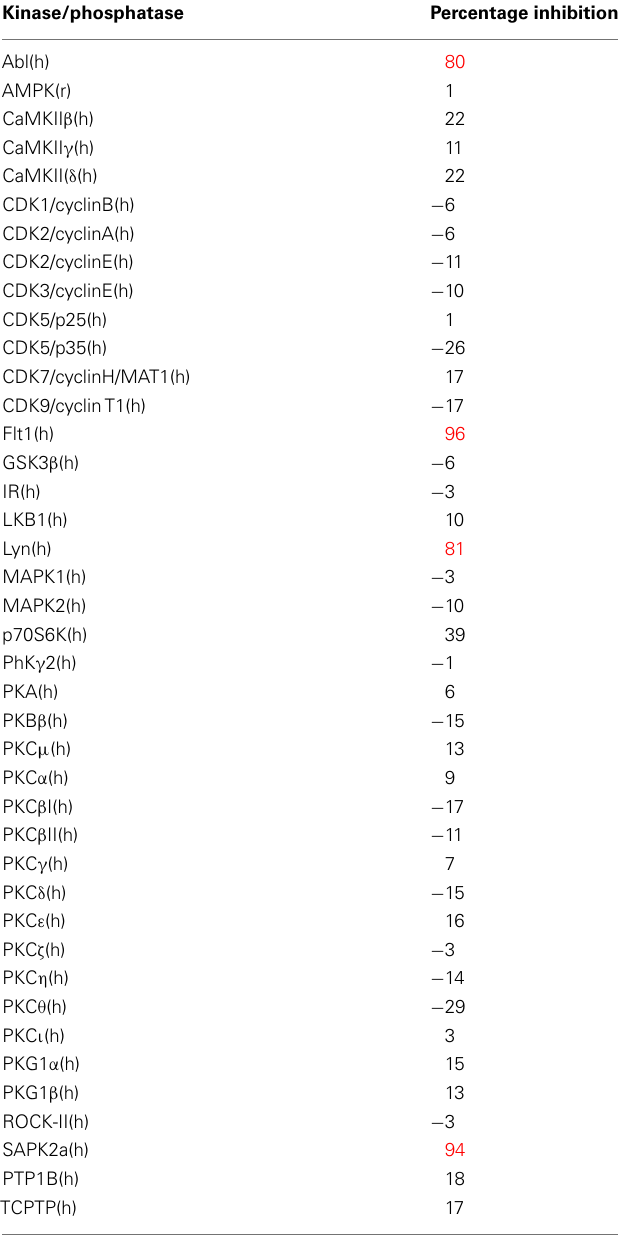
Table 1 |Activity expressed as percentage inhibition of 10 μ M BIRB0796 on 39 kinases and 2 phosphatases within Millipore’s Safety and Liability